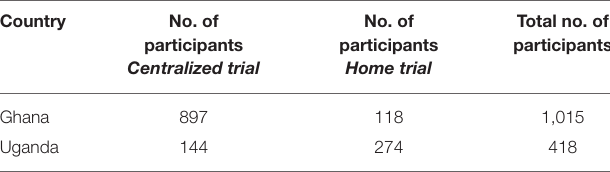
TABLE 2 | Total number of participants in centralized and home tasting trials in Ghana and Uganda.